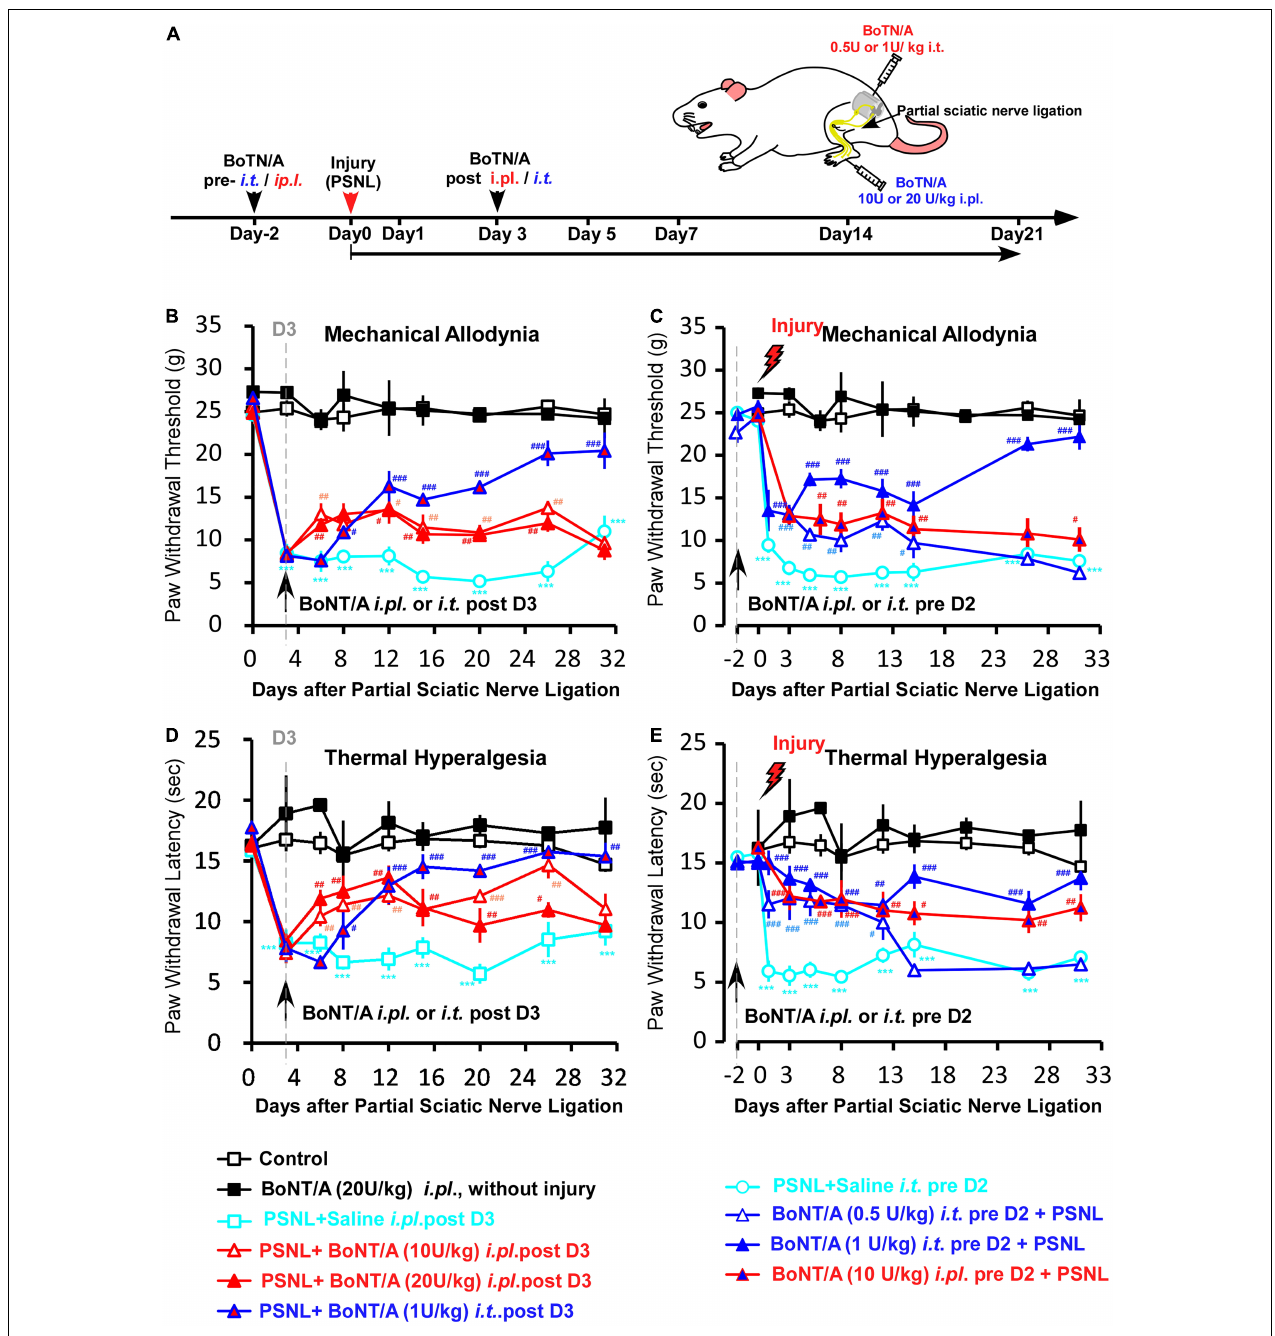
FIGURE 4 | A low dose of BoNT/A intrathecal ( i.t ) pre-administration prevents PSNL-induced mechanical allodynia and thermal hyperalgesia in rats. (A) A schematic illustration of the experimental protocol. Botulinum toxin A (BoNT/A) was intrathecally ( i.t ) injected into spaces between the L5 and L6 spinal segments) 2 days before surgery or into the plantar surface of the paw ( i.pl. ) 3 days after the PSNL surgery in rats. Mechanical allodynia and thermal hyperalgesia behavior tests were performed after PSNL surgery. Mechanical allodynia (B,C) and thermal hyperalgesia (D,E) were compared between the control (nerve exposed without ligation), Saline i.t. pre D2 + PSNL (saline i.t. administrated to rats 2 days before PSNL surgery), PSNL + Saline i.pl. post D3 (saline i.pl. administrated to rats 3 days after PSNL surgery), BoNT/A (20 U/kg i.pl. administrated to rats without injury), PSNL + BoNT/A i.pl. post D3 (BoNT/A 10 U/kg or 20 U/kg i.pl. administrated to rats 3 days after PSNL surgery), PSNL + BoNT/A i.t. post D3 (BoNT/A 1 U/kg i.t. administrated to rats 3 days after PSNL surgery), BoNT/A i.t. pre D2 + PSNL (BoNT/A 0.5 U/kg or 1 U/kg i.t. administrated to rats 2 days before PSNL surgery) and BoNT/A i.pl. pre D2 + PSNL (BoNT/A 10 U/kg administrated to rats 2 days before PSNL surgery) groups. Statistical analysis revealed that the paw withdrawal threshold and paw withdrawal latency were significantly higher after BoNT/A application. Six mice were used in each group. Data are represented as the mean ± SEM. Non-parametric Kruskal-Wallis test was used for comparison. *** p < 0.001 compared to the sham group; ### p < 0.001, ## p < 0.01, and # p < 0.05 compared to the PSNL group.